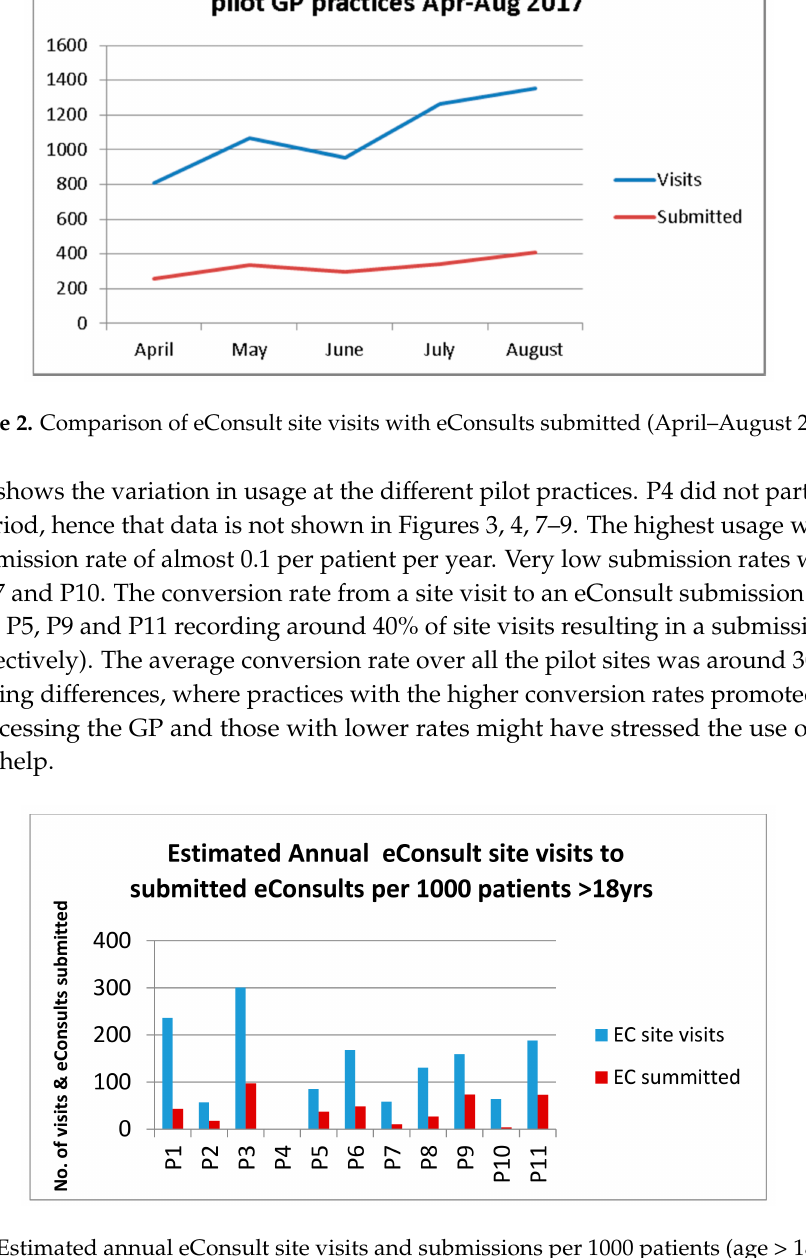
Figure 3. Estimated annual eConsult site visits and submissions per 1000 patients (age > 18 years *). * estimated number of patients aged 18+ from Information Services Division (ISD) count of patients aged 15–24